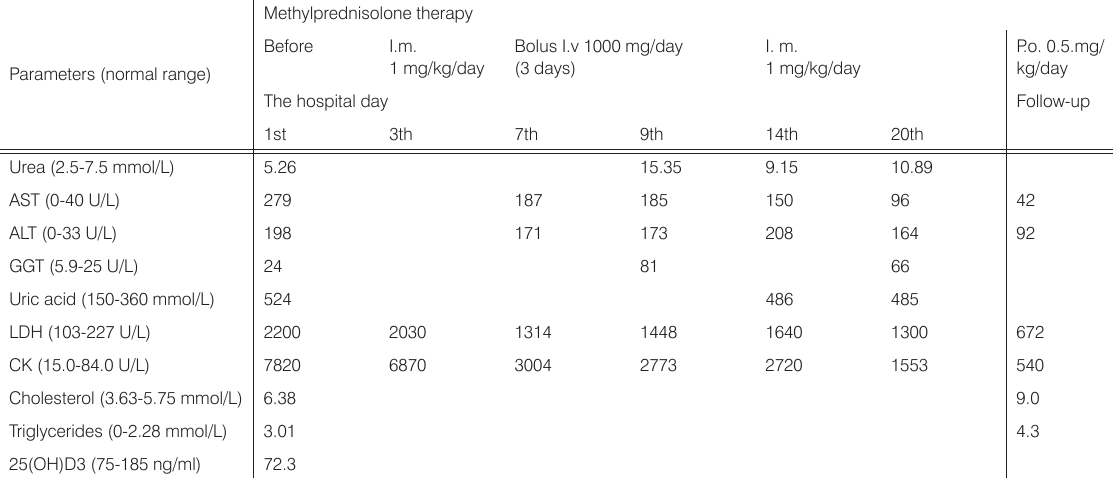
Parameters (normal range)